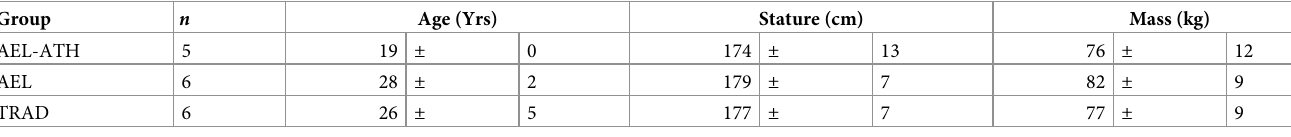
Table 1. Participant characteristics at baseline for each training